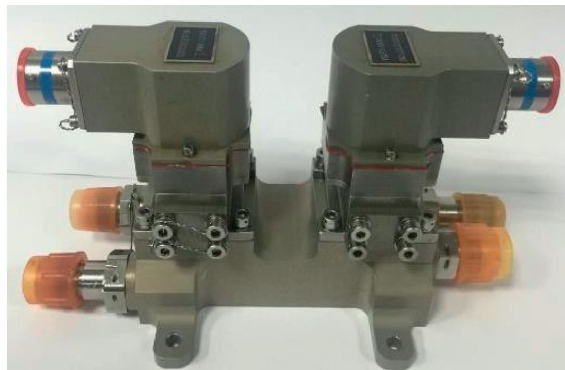
Figure 16: Te new brake pressure servo